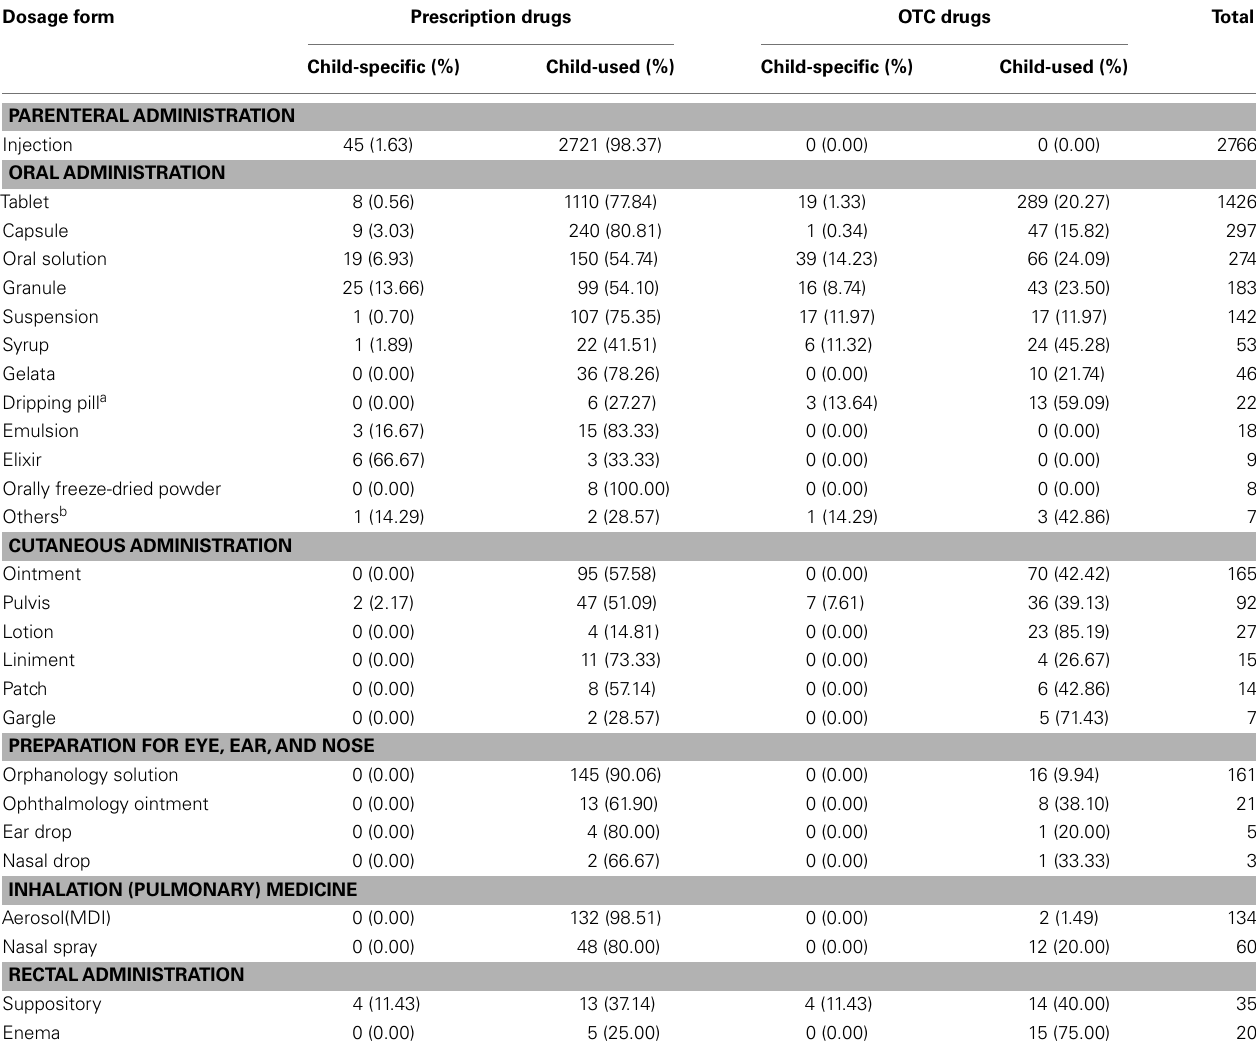
Table 2 | Dosage forms of pediatric medicines